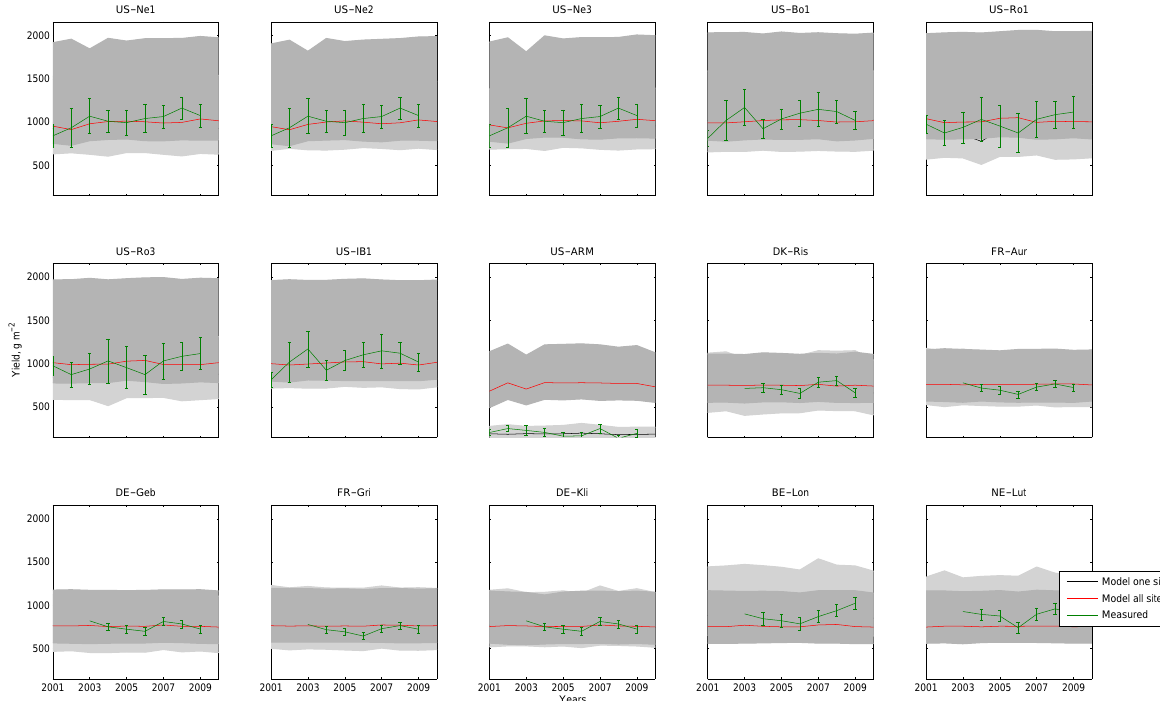
Figure A3. Yield predictions for all years for all sites fitted using all available data at each individual site and at all sites together. Grey shaded areas represent 95% confidence intervals drawn from the posterior distribution.